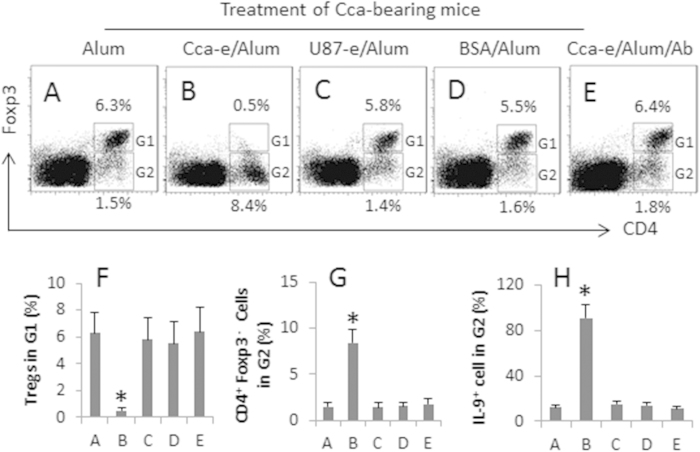
Cca-specific Th2 response inhibits Tregs in Cca tissue.Cca-bearing mice were treated as denoted above each dot plot panel of A–E. Cca tissue was excised from the mice and processed for single cells and analyzed by flow cytometry. A–E, the dot plots indicate the frequency of CD4+ or/and Foxp3+ cells. F, the bars indicate the summarized frequency of Tregs in gate 1 (G1) of A–E. G–H, the bars indicate the summarized CD4+ Foxp3- cell frequency (G) and IL-9+ cell frequency (H) in gate 2 (G2) of A–E. Ab: Mice were received a neutralizing anti-IL-4 antibody. The data of bars are presented as mean ± SD. *, p < 0.01, compared with group A. Each group consisted of 10 mice. The data are representatives of 10 independent experiments.